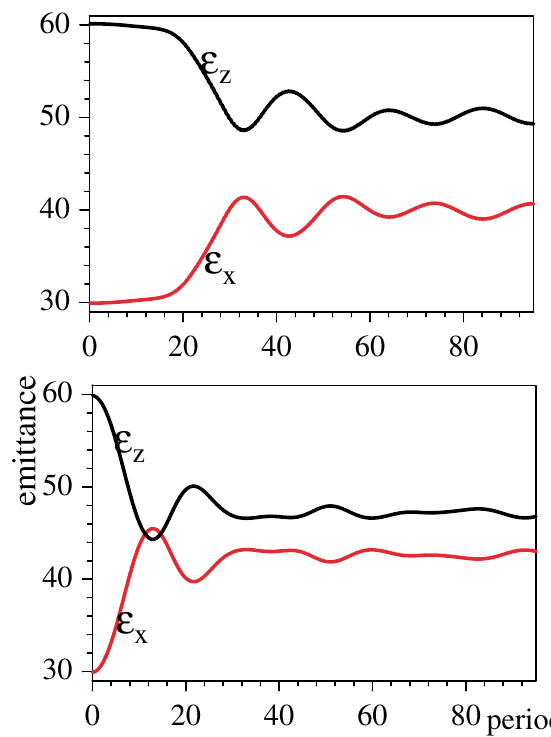
FIG. 7. (Color) Evolution of rms emittances (arbitrary units) (cid:3) 1 : 04 , (cid:10) (cid:3) 0 : 8 , and (cid:19) (cid:3) 2 with initial KV =(cid:10) =(cid:10) =(cid:19) for (cid:10) z x x z x 0 x (top panel) and WB (bottom panel). Units on the abscissa are betatron periods in x in the absence of space